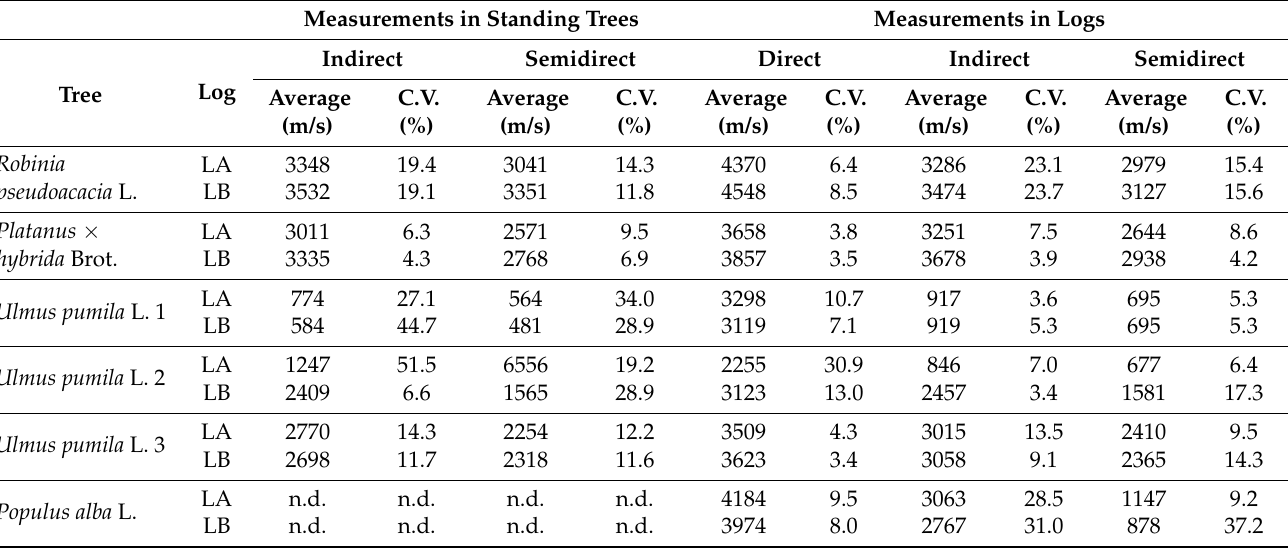
Table 1. Longitudinal velocities obtained using USLab and coefficients of